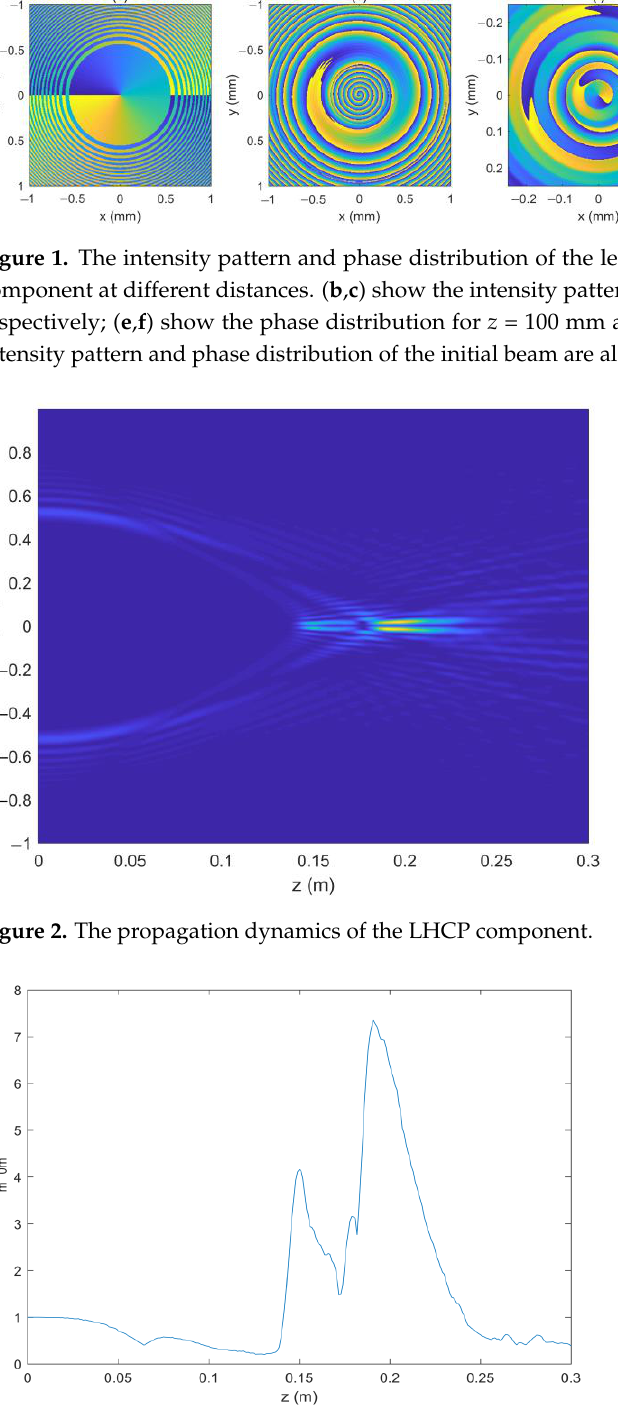
Figure 3. The “abruptly autofocusing” property of the LHCP component.